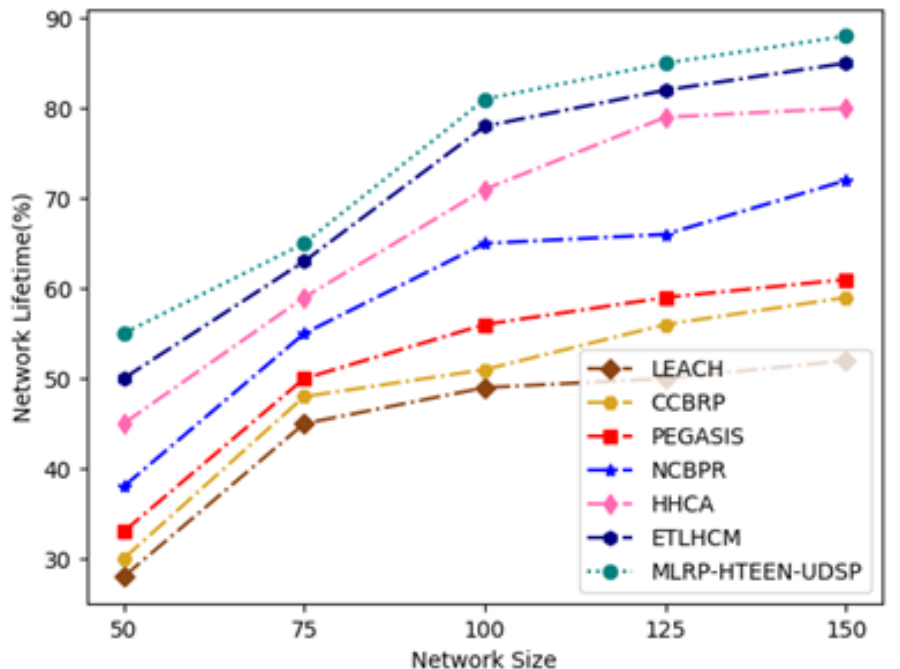
Figure 10. Comparison of network Lifetime.